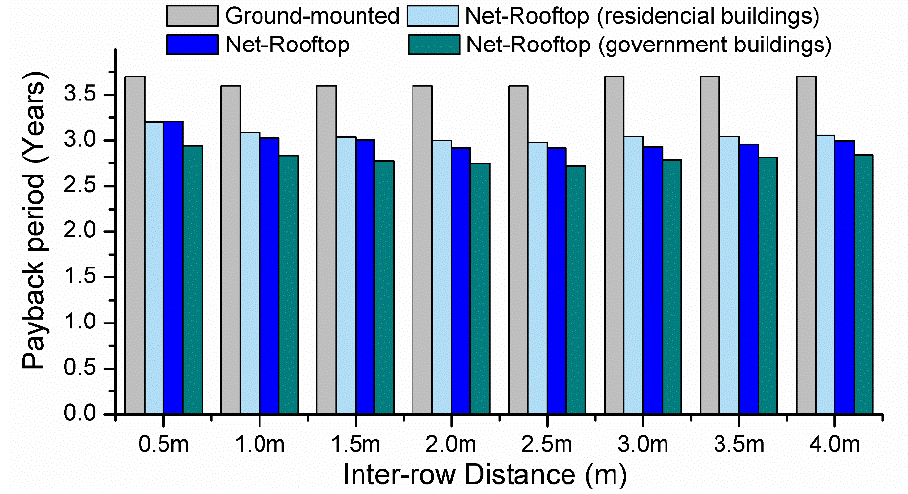
Figure 10. Payback periods of ground-mounted and rooftop PV configurations at various interrow distances.